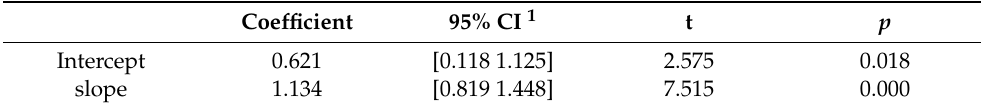
Table 2. Linear regression summary for predicting stage A end